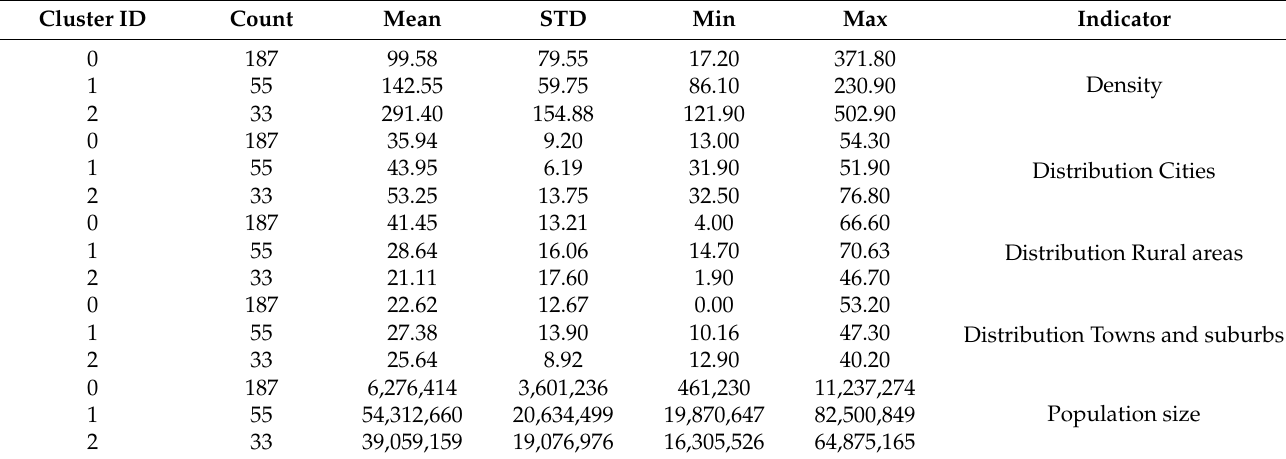
Table 2. Cluster group description by population, created by authors.